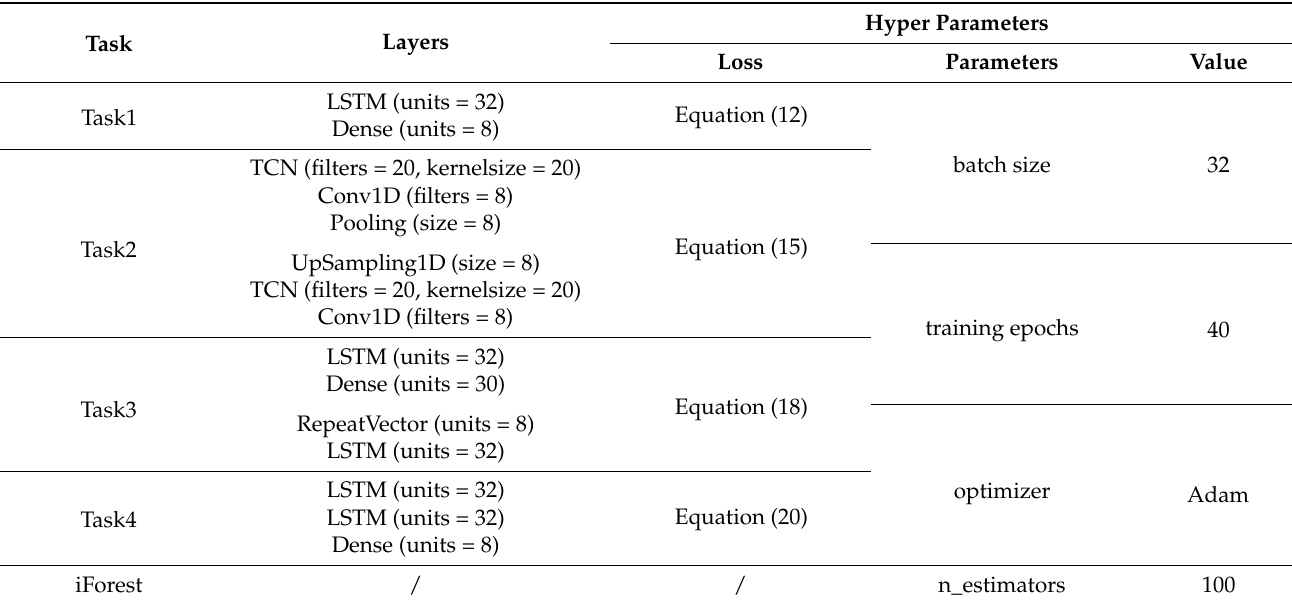
Table 2. MTAD parameter